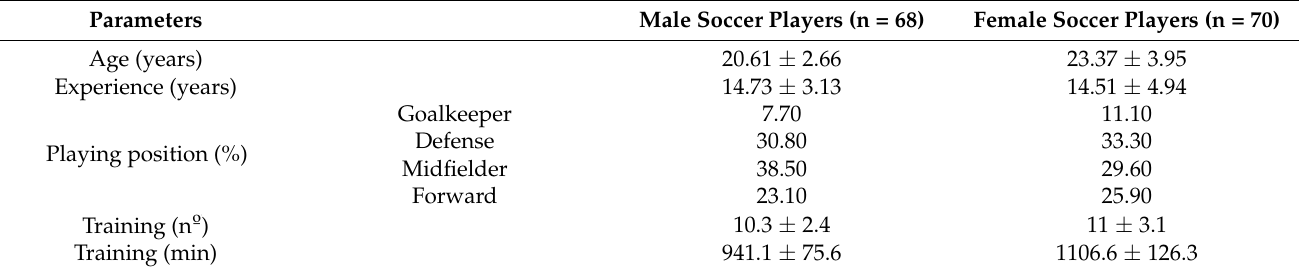
Table 1. General characteristics of the sample and of the training session carried out.